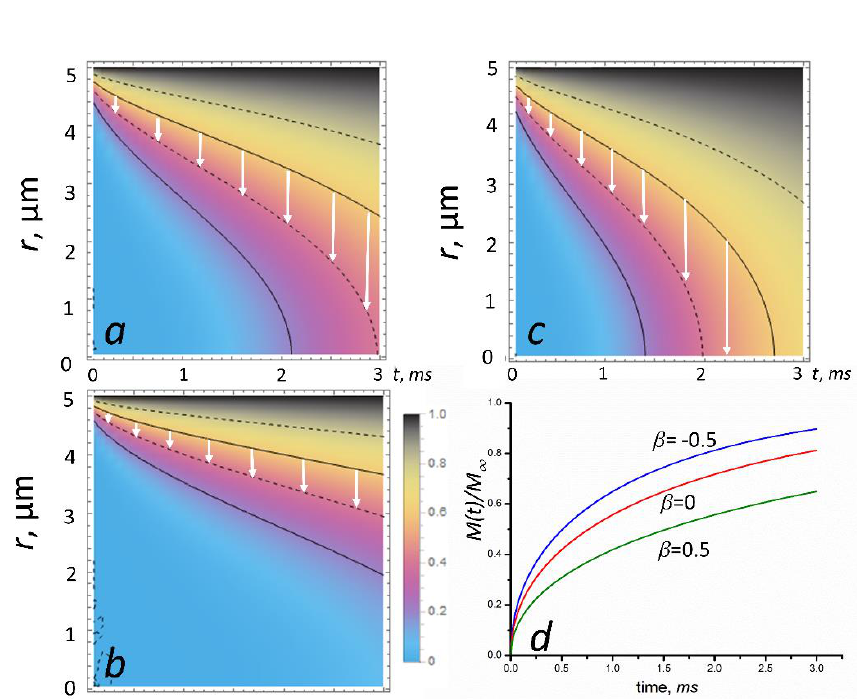
Figure 2. A MF’s effect on diffusion in a sphere: the contour plots of n(t , r)/n 0 given by Equation (10). The sphere is initially at a uniform zero concentration and the surface concentration is maintained constant at n 0 . The curves represent n(t , r)/n 0 : ( a ) with no magnetic field ( β = 0); ( b ) with a magnetic field corresponding to β = 0.5 (paramagnetic species); ( c ) with a magnetic field corresponding to β = − 0.5 (diamagnetic species). The calculations of n(t , r)/n 0 were performed for R = 5 µ m and D = 10 − 9 m 2 /s in the time interval 0 < t < 3 ms. The legend shows the concentration n(t,r)/n 0 , which varies from 0 to 1. The white arrows show the direction of the diffusion front propagation. Figure ( d ) shows the total amount of diffusing substance entering or leaving the sphere as a function of time for β = 0, − 0.5, and